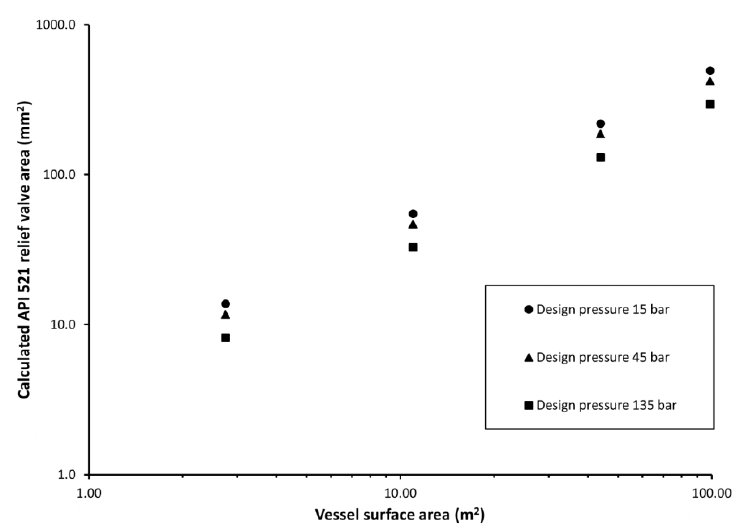
Figure 2. API 521 relief valve sizing results for the four vessel sizes investigated. Three different design pressures are applied for each vessel size and for each design pressure, a high and low operating (initial) pressure is applied.